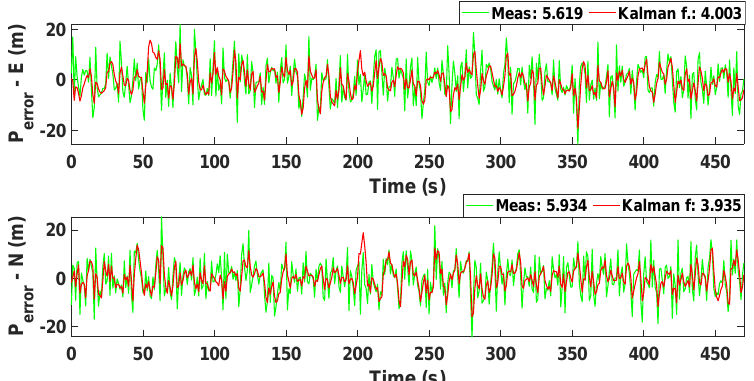
Figure 10. Simulation of Kalman filter for autonomous drive.